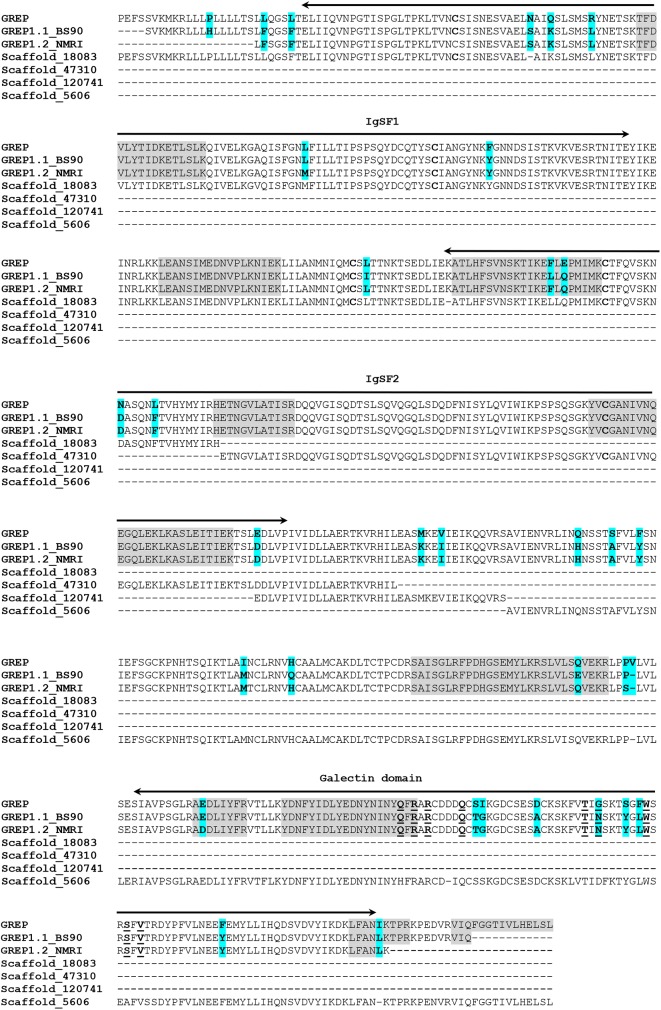
Multi-sequence alignment and comparison of the predicted galectin-related protein (GREP) sequences with the BS-90 and NMRI Biomphalaria glabrata variant GREP proteins.Amino acid sequence predicted from an RNAseq assembly (RNAseq-GREP; KM975647) [18] is compared to 4 predicted proteins encoded within Scaffolds18083, 47310, 210741 and 5606. Near-complete ORFs for the GREP, encoding IgSF1/IgSF2 domains and galectin binding domain, were amplified from BS-90 (GREP1.1) and NMRI (GREP1.2) snail cDNA. Original peptide sequences (shaded grey) aligned with the translated scaffolds and the GREP1.1 and 1.2 proteins. Cysteines involved in the formation of Ig-loop domains are shown in boldface, while residues associated with the sugar-binding pocket of the galectin domain, as predicted by NCBI delta-blast, are shown as underlined bolded letters (Q/H, R, R, T/Q, N/G/S, W, A/S, V). Amino acid differences between GREP [18], GREP1.1 and GREP 1.2 are highlighted in blue.